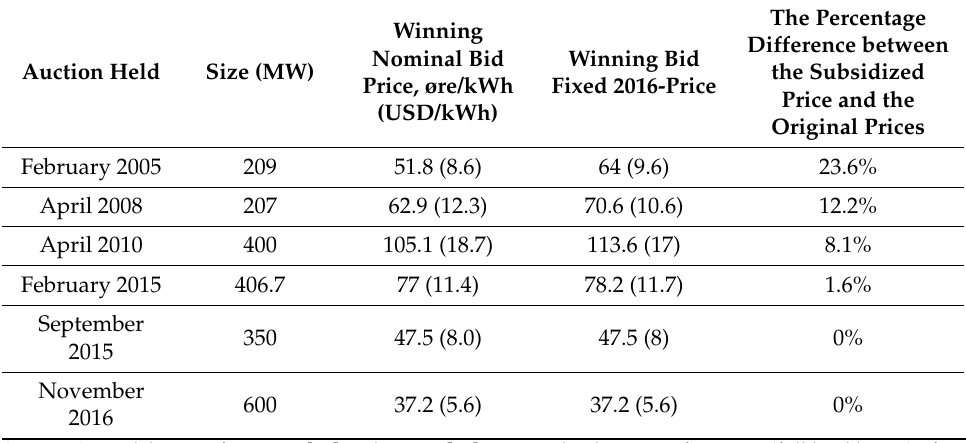
Table 3. State subsidy (price premium) of large-scale offshore wind tenders, 2005–2016. Auction Held Size (MW)